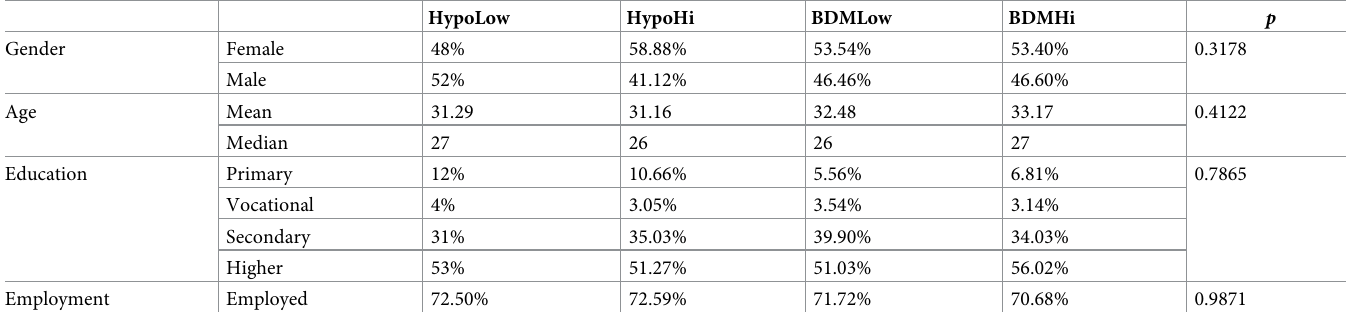
Table 6. Experiment 2: Comparison of characteristics of the respondents in all treatments.